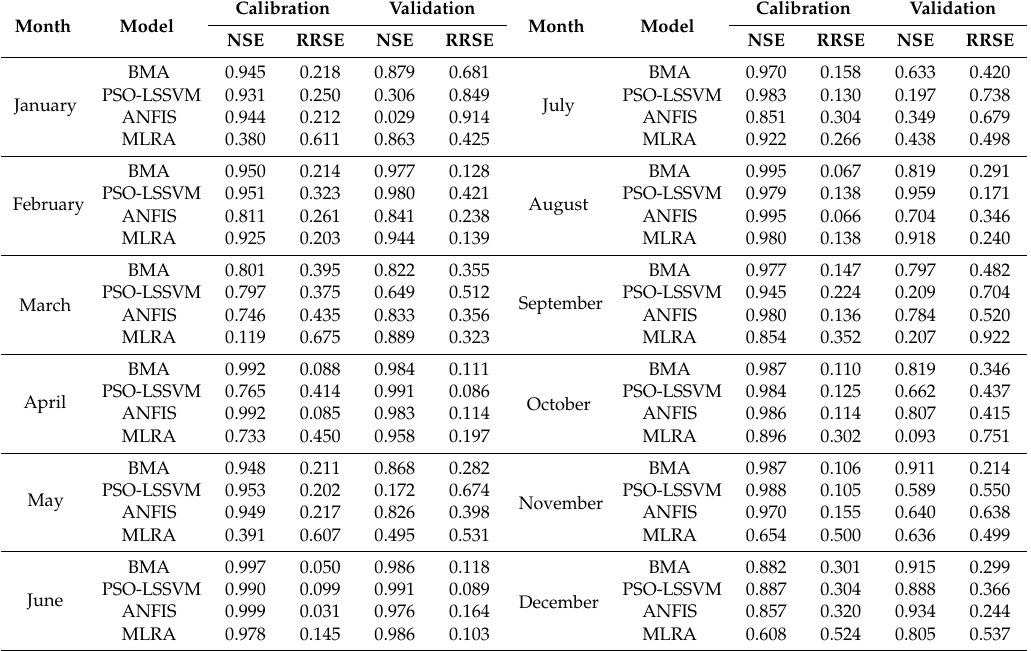
Table 9. The results of NSE and RRSE for the monthly power output simulated by PSO-LSSVM, ANFIS, MLRA, and BMA models.